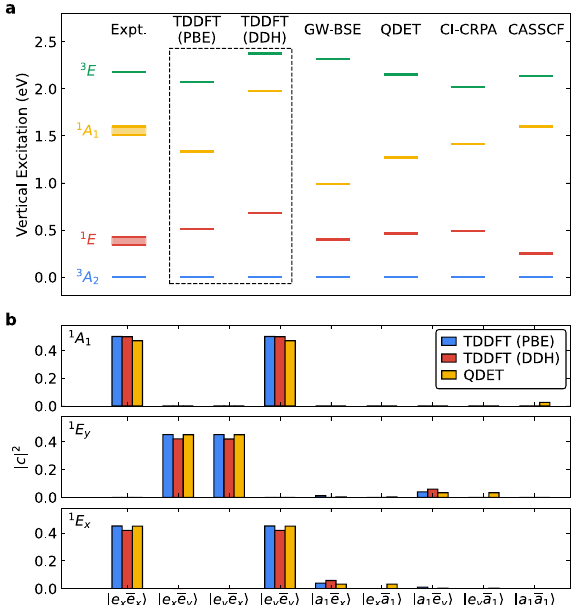
Fig. 2 Many-body electronic states of the NV − center in diamond. a Vertical excitation energies (VEEs) of the low-lying many-body electronic states at the ground state geometry, computed using time-dependent density functional theory (TDDFT), and using PBE and DDH functionals are shown in the rectangle. Experimentally inferred VEE of the 3 E state and zero-phonon absorption energies of the 1 A 1 and 1 E states are from refs. 49 – 52 . We also report theoretical results obtained using GW and the Bethe – Salpeter Equation (BSE) 21 , quantum defect embedding theory (QDET) 29 , results obtained from the constrained random-phase approximation solved by con fi gura- tion interaction (CI-CRPA) 23 , and quantum chemistry results for clusters from complete active space self-consistent fi eld (CASSCF) 22 calculations. b Contribution of Slater determinants of single excitation ( e x e x j